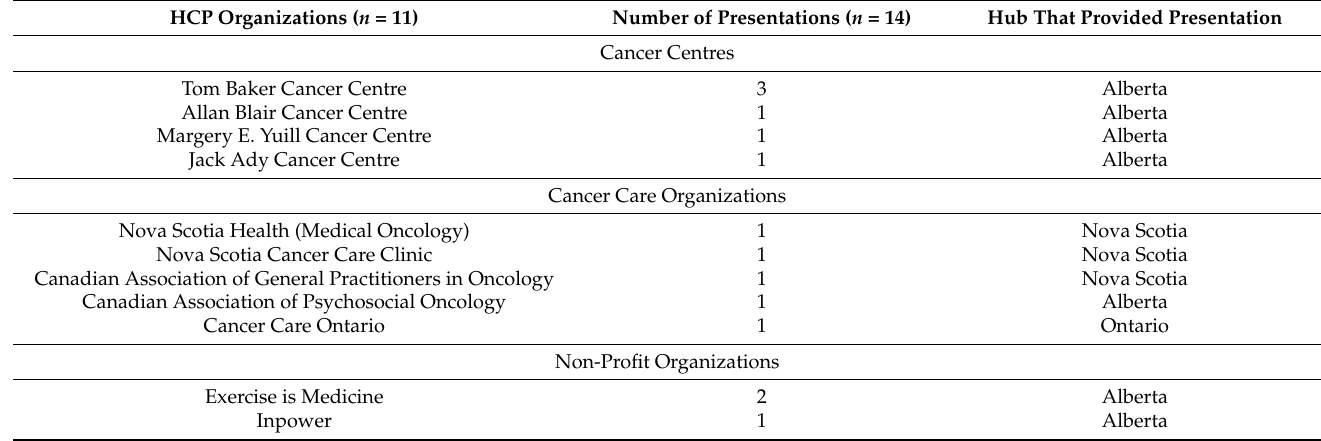
Table 4. Presentations to HCP